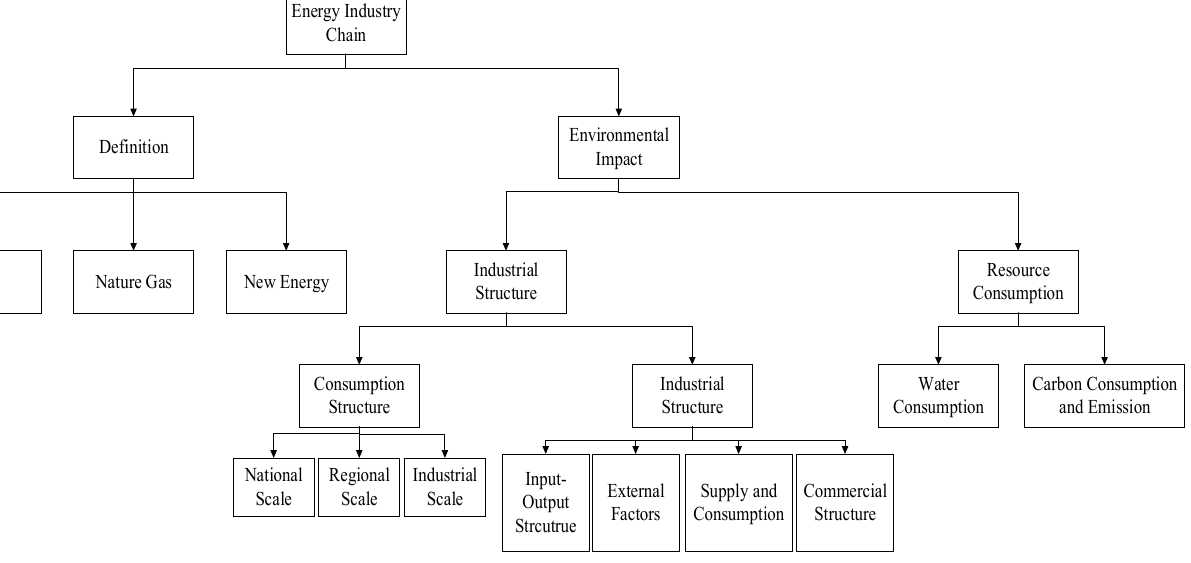
Figure 2. Structure of Study on Energy Industry Chain.